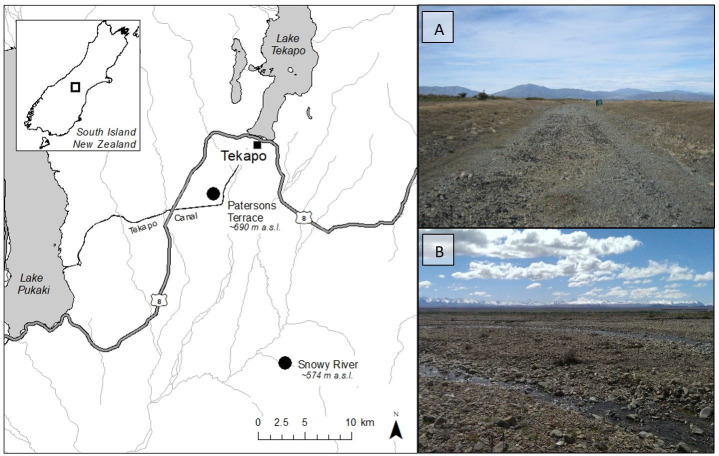
The location of Patersons Terrace and Snowy River in the Mackenzie basin in the central South Island, New Zealand (inset).(A) Patersons Terrace, an unused gravel road. (B) Snowy River, an alluvial fan with braided river characteristics. This figure contains data sourced from the LINZ Data Service licensed for reuse under CC BY 4.0.